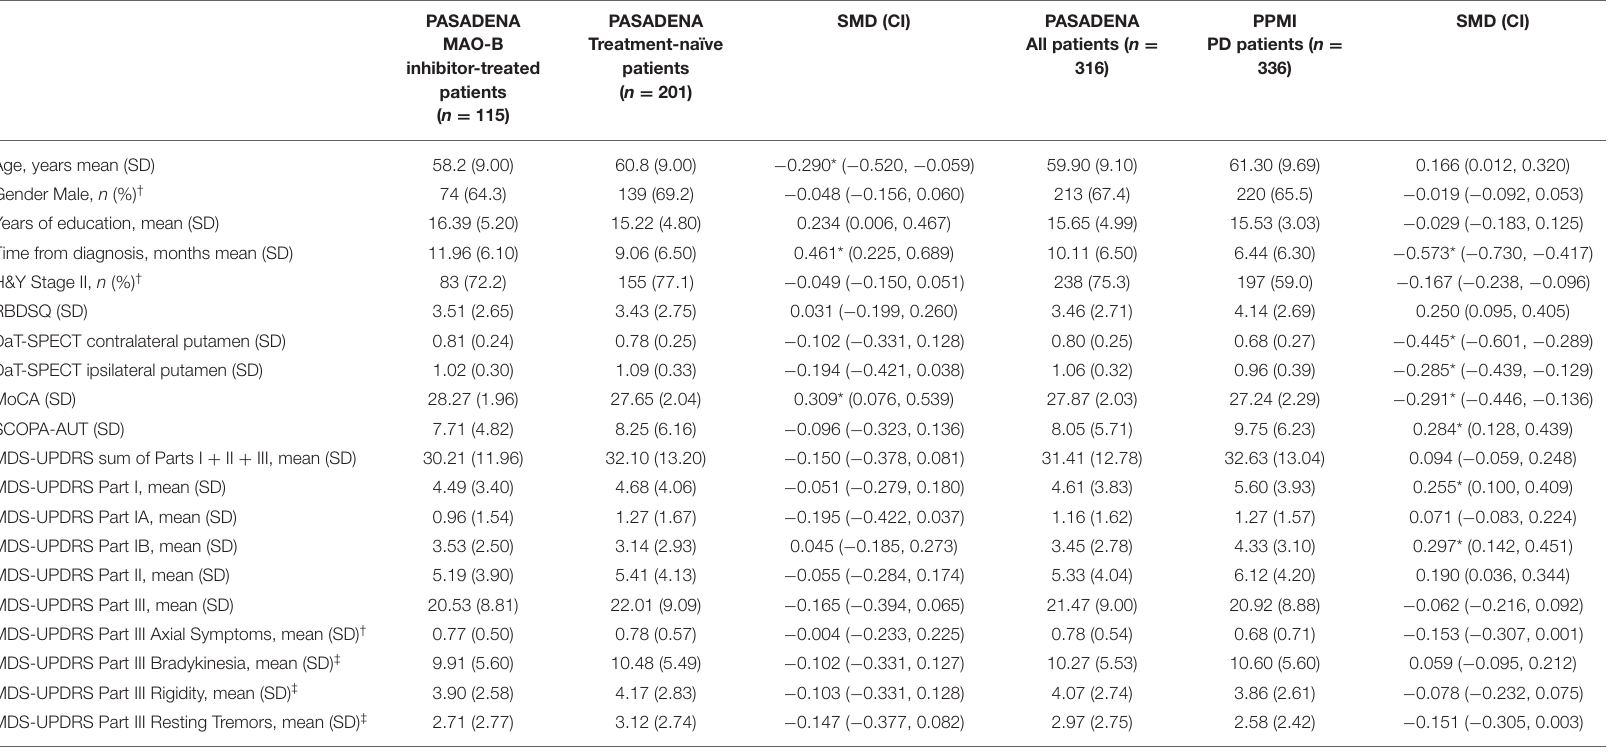
TABLE 1 | PASADENA; MAO-B inhibitor-treated vs. treatment-naïve patients, and PASADENA (all patients) vs. PPMI.